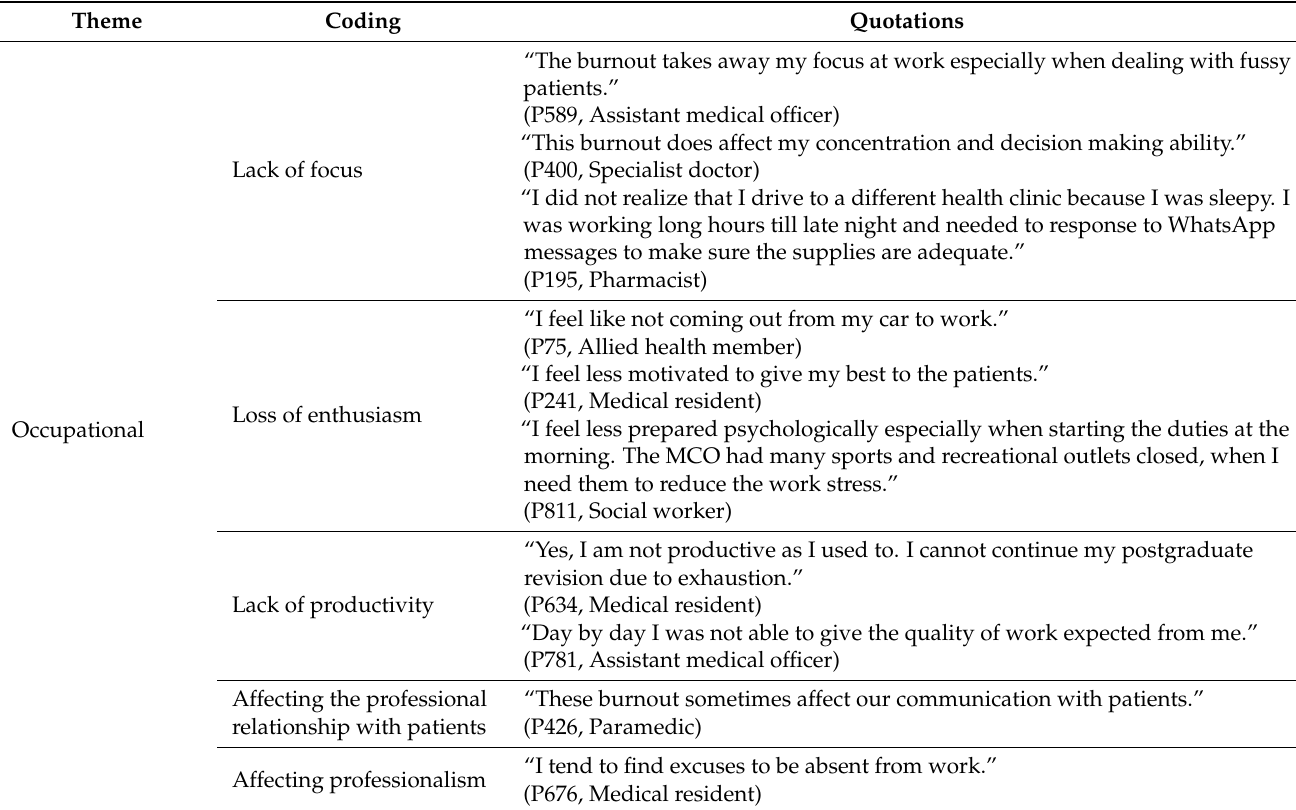
Table 8. Common self-reported burnout impacts in